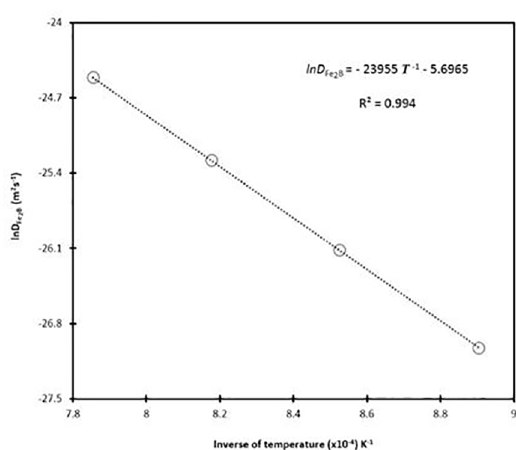
Figure 8. The temperature dependence of boron diffusion coefficient in the Fe B layer. 2 Table 3. Comparison of activation energy for boron diffusion in AISI S1 steel with other borided materials.